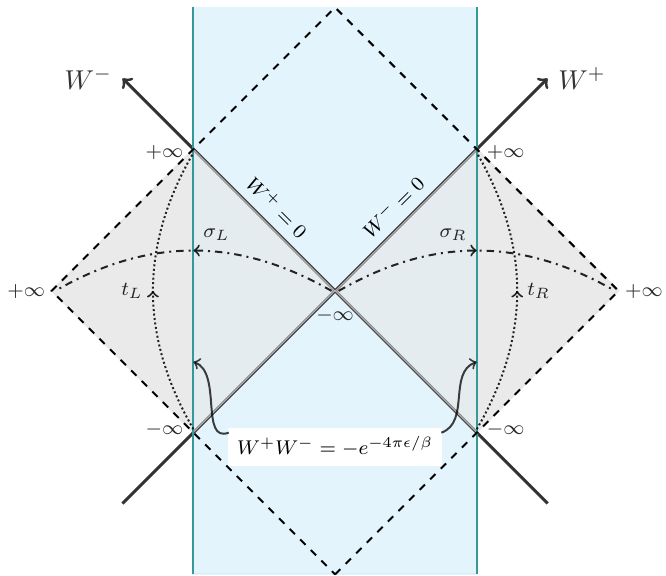
Figure 3. The AdS 2 eternal black hole in Lorentzian signature (colored in blue). We introduce three coordinates y ± , y ± and W ± . We show the patch described by y ± R L W ± covers inside the dashed